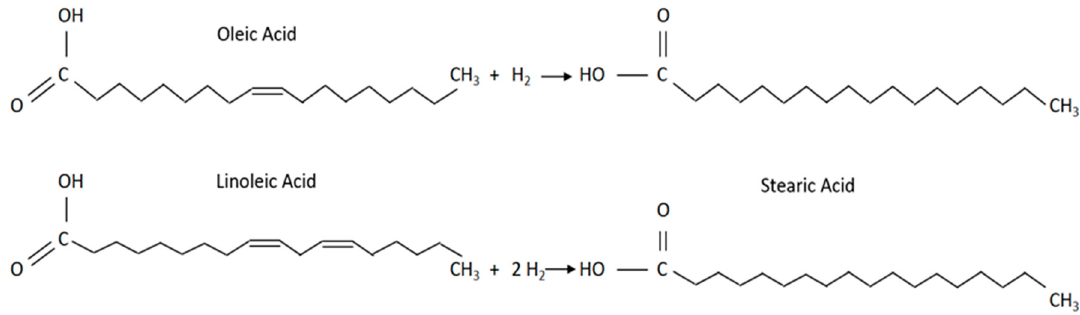
Figure 2. Hydrotreatment of fatty acids.